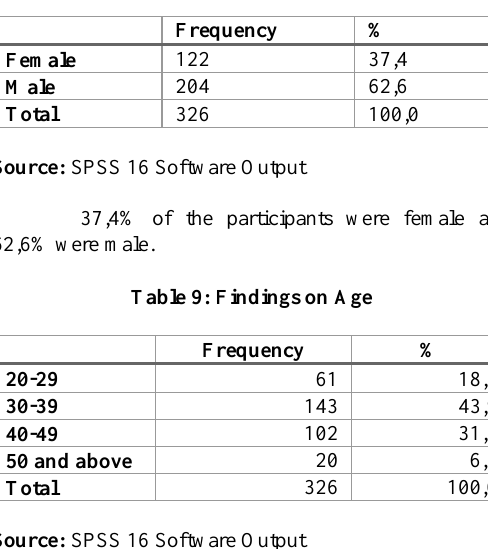
Table 8: Findings on Gender